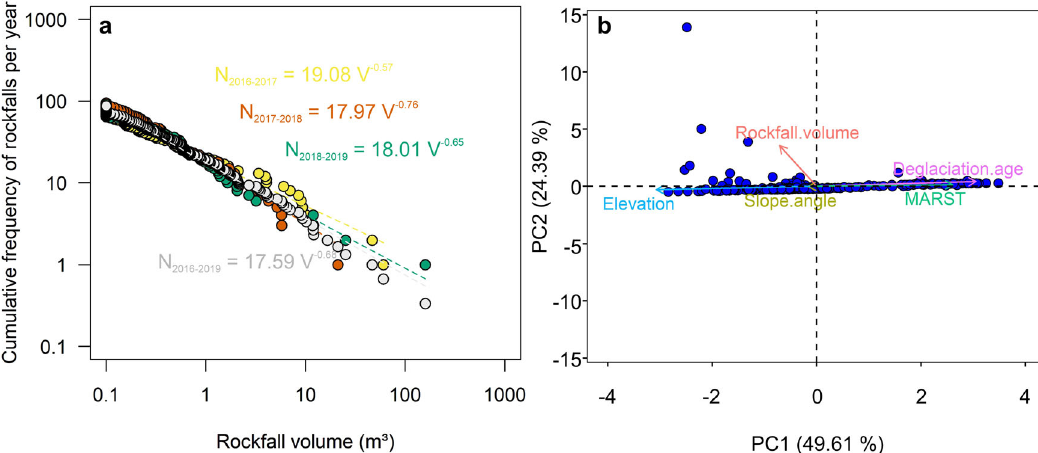
Fig. 3 Rockfall events and statistical analysis of controlling factors. a Rockfall frequency-magnitude distribution for individual periods (2016 – 17 in yellow, 2017 – 18 in red, 2018 – 19 in green) and for the entire 2016 – 2019 period (in grey) in the Hungerli Valley. Linear correlation r 2 of power laws is between 0.98 and 0.99 with p < 0.001. b PCA of rockfall variance between fi ve variables: deglaciation age (i.e. proxy for paraglacial condition, elevation (proxy for frost cracking), MARST (proxy for permafrost), slope angle, and rockfall